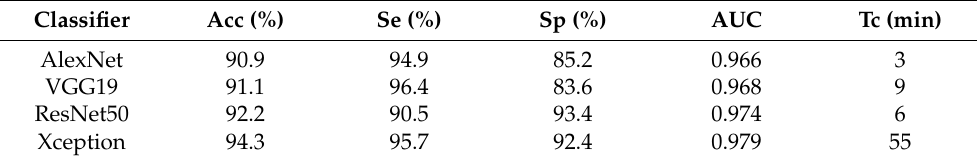
Table 4. Performance of four types of neural networks on the UST-CWT datasets. Classifier